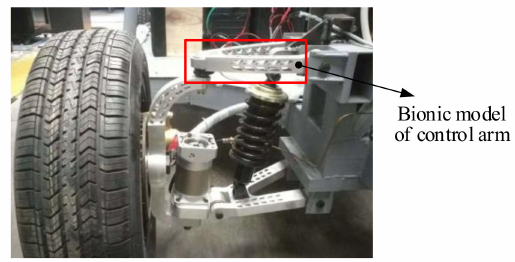
Figure 21. Real vehicle test of the new control